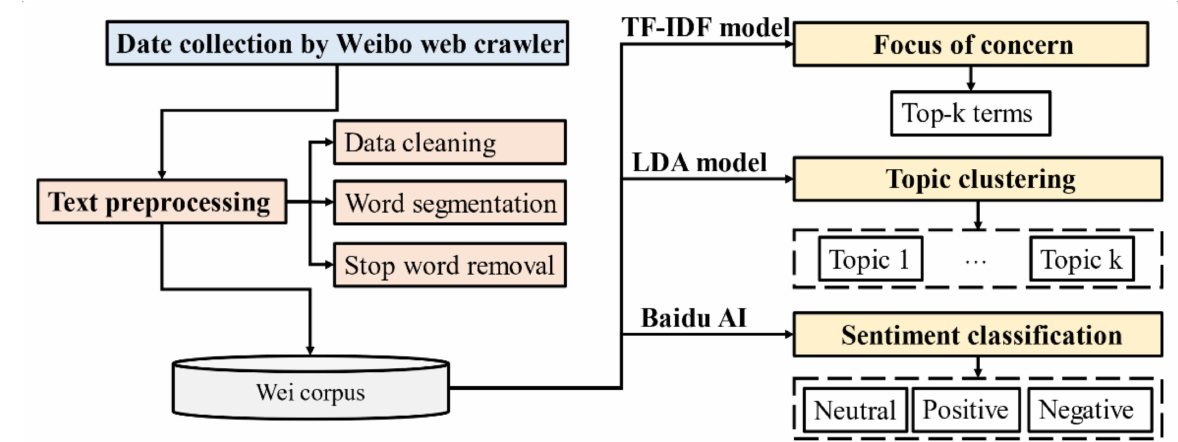
Figure 2. A hybrid framework integrating multiple natural language processing (NLP) methods.